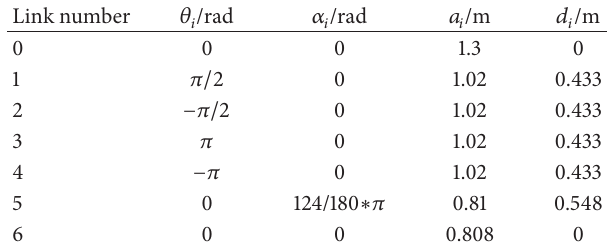
Table 2: D-H parameters of a space-based manipulator